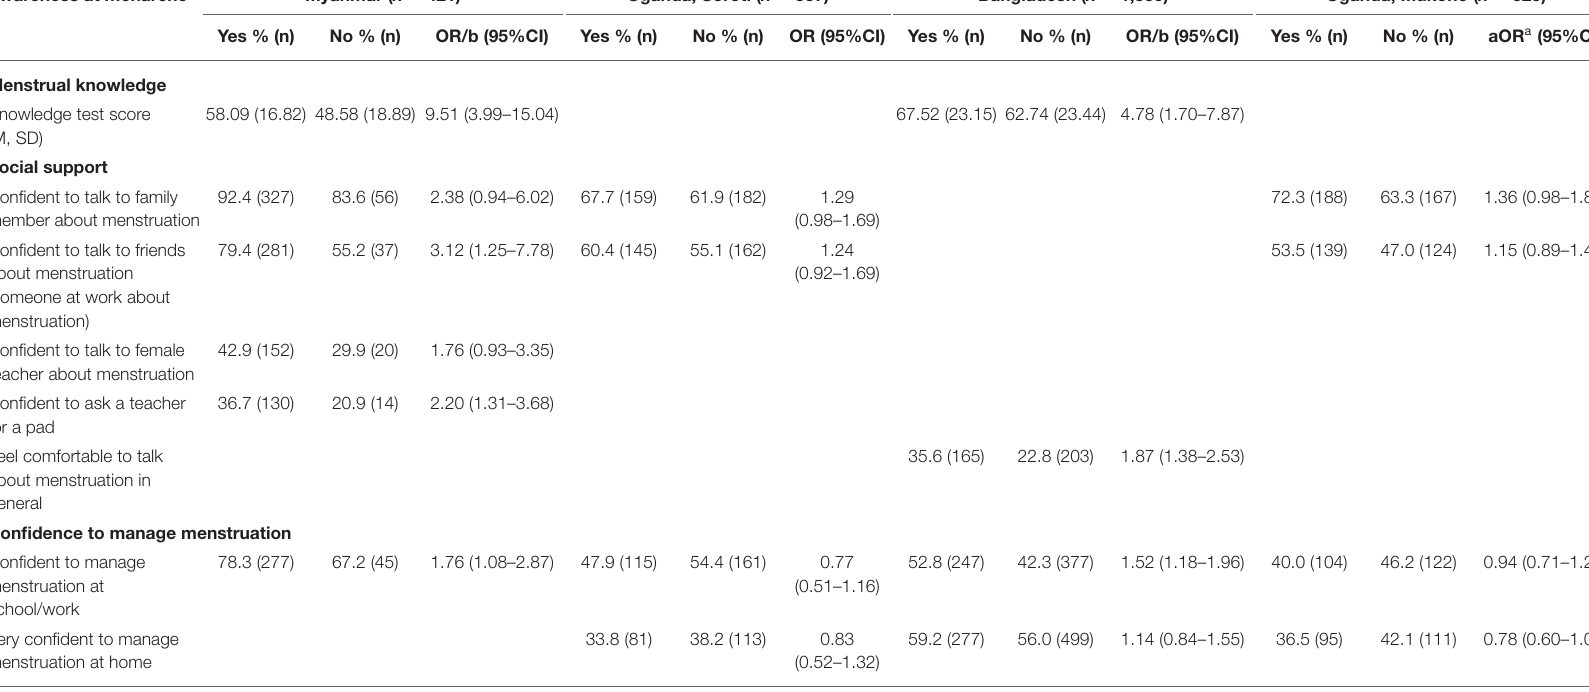
TABLE 4 | Relationships between awareness of menstruation at menarche and menstrual knowledge, social support, and confidence to manage menstruation. Awareness at menarche Myanmar ( n = 421) Uganda, Soroti ( n =